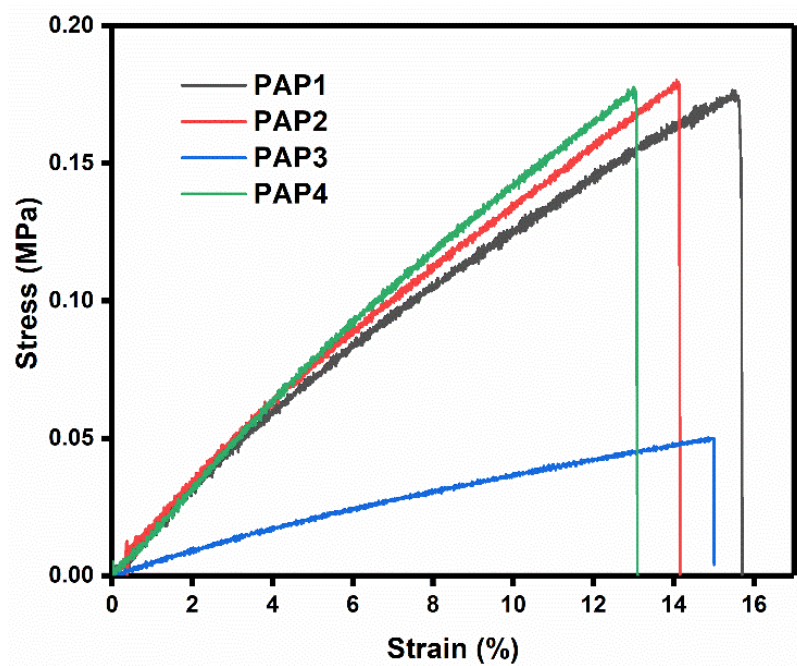
Figure 9. Tensile properties of the All-in-One